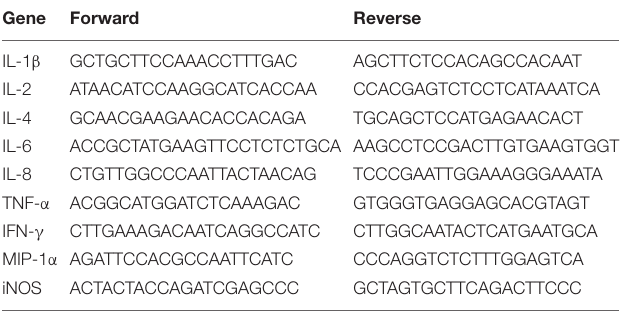
TABLE 1 | Primer sequences for quantitative RT-PCR (Primer, 5 (cid:48) → 3 (cid:48)